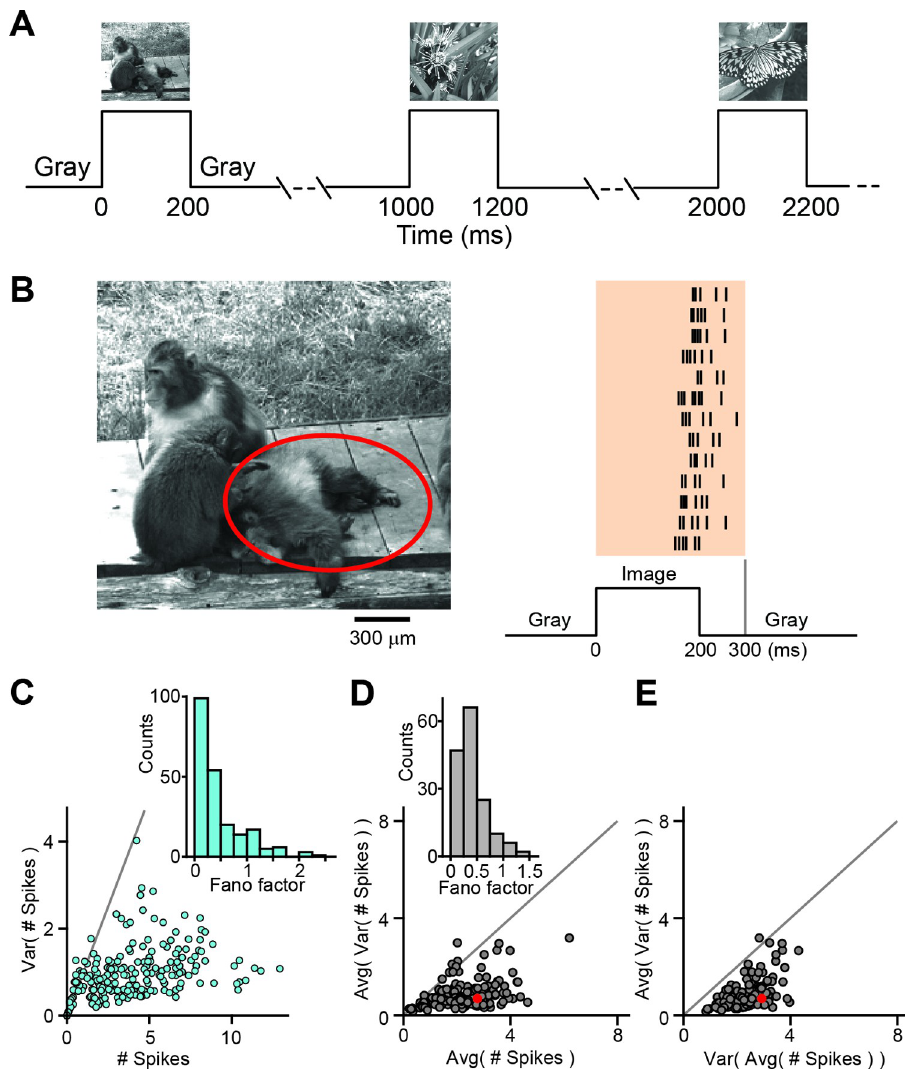
Fig 1. Overview of salamander ganglion cell responses to natural images. A) Schematic of the sequence of 300 natural images presented individually in a pseudo-random fashion for 200 ms each, with an inter-stimulus-interval of 800 ms. B) Left: One of the 300 natural images, overlaid with the 3-sigma outline of the receptive field of a sample retinal ganglion cell. Right: Raster plot of spike times recorded from the sample cell for 13 repeated presentations of this image. Every row corresponds to one image presentation. At the bottom, the timeline of stimulus presentation is shown, indicating the 200-ms presentation time, surrounded by periods of gray illumination. The vertical gray line at 300 ms marks the end of the applied window for counting spike numbers. C) Spike count variance (y-axis) vs. average spike count (x-axis) from the sample cell for each of the 300 images. The gray line denotes the expected relation of variance and average spike count for a Poisson process. Inset: Histogram of Fano factors for each image, excluding those with zero spikes. D) Average over images of the single-image spike count variance as a measure of response noise (y-axis) vs. the average spike count over all images as a measure of typical signal size (x-axis), shown for each recorded cell. Inset: Histogram of Fano factors for each cell, averaged over images. N = 156 cells from 9 retinas. E) Average over images of the single-image spike count variance as a measure of response noise (y-axis) vs. variance over images of the average spike count per image as a measure of response range (x-axis), shown for each recorded cell. The sample cell is marked in red in D and